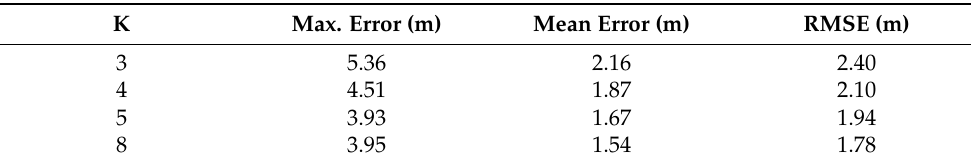
Table 2. The estimation accuracy results (maximum error, mean value, and root mean square error (RMSE)) calculated for varying numbers of reference modules considered for the second phase of the proposed localization algorithm.